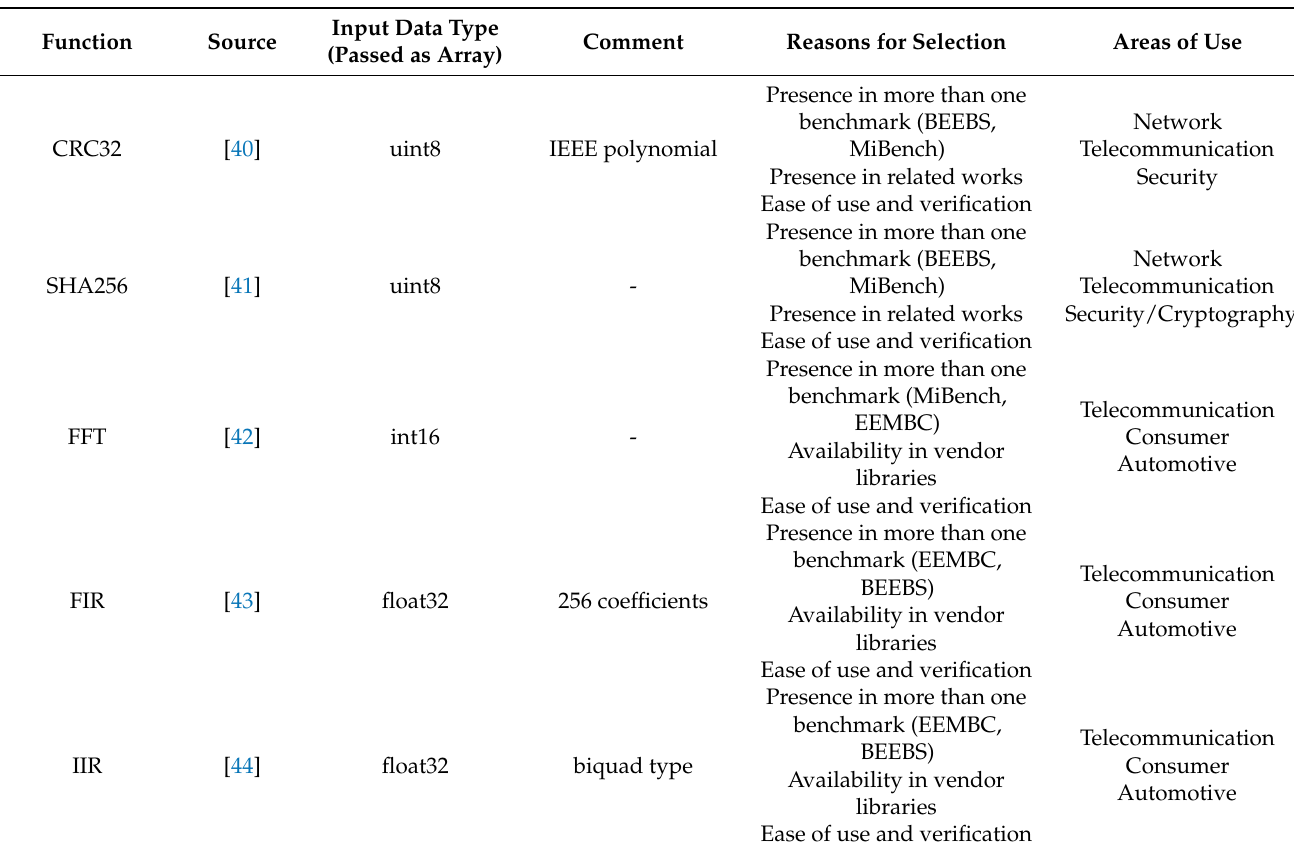
Table 2. The details of the functions used for the performance evaluation in selected programming